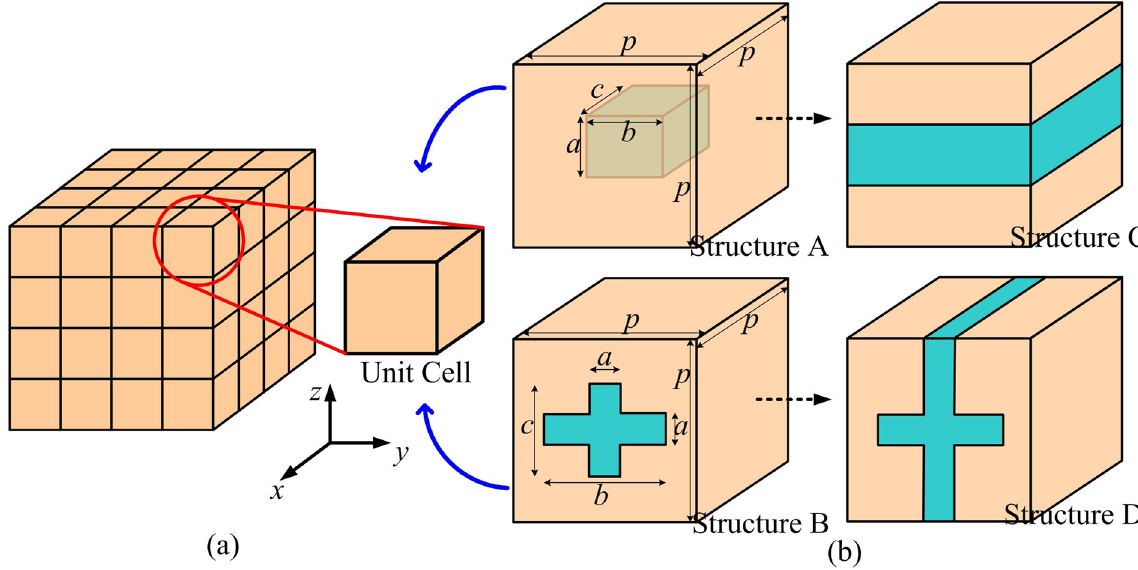
Figure 4. The schematic to construct the artificial materials used in the device. ( a ) The artificial material with required thermal conductivity can be constructed by unit cells in regular arrangement. ( b ) The unit cells with different structures are designed to meet the requirements in different pyramids in device. In structure A, a cubic hole is drilled in the base material (brass). In structure B, a cross-shaped through-hole is drilled on the base material. Structure C and structure D are simplified structures from structure A and B,